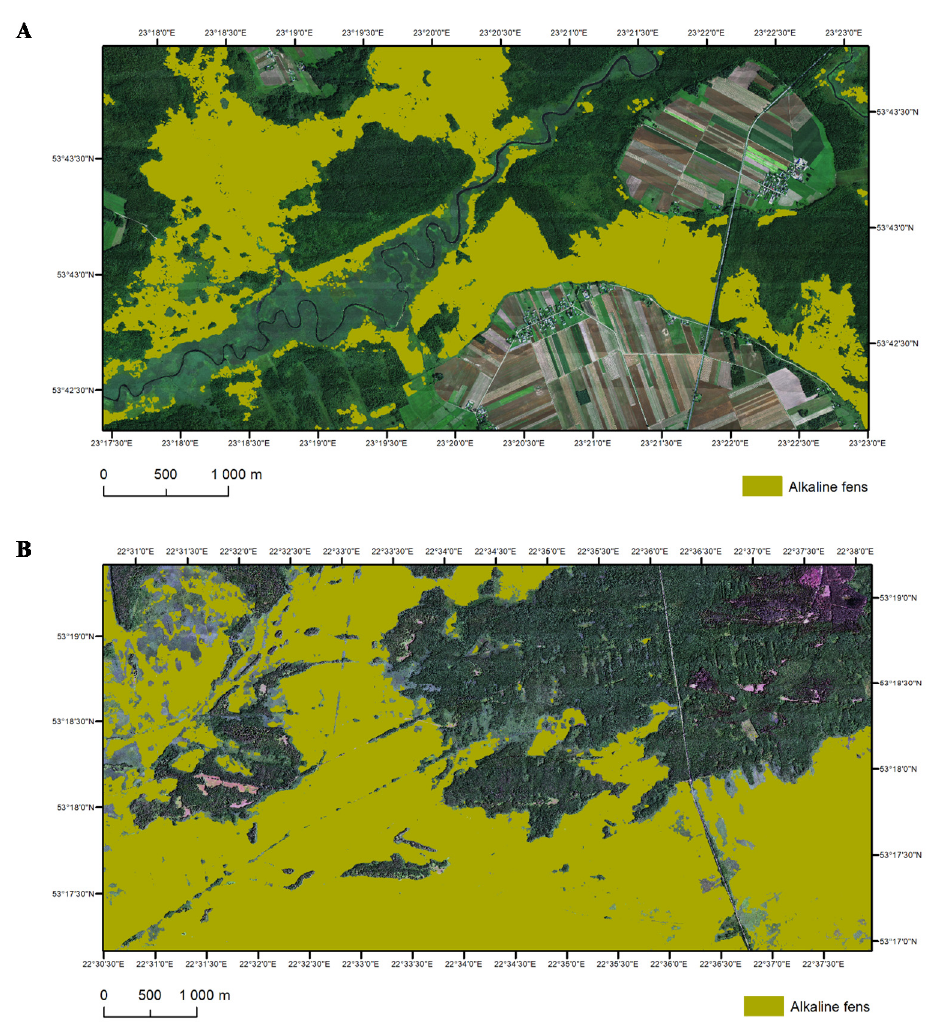
Figure 13. Distribution maps of alkaline fens obtained from the best classification results performed on chosen sub-products in the Biebrza River Valley (( A ): Upper Biebrza—UB, ( B ): Lower Biebrza—LB).